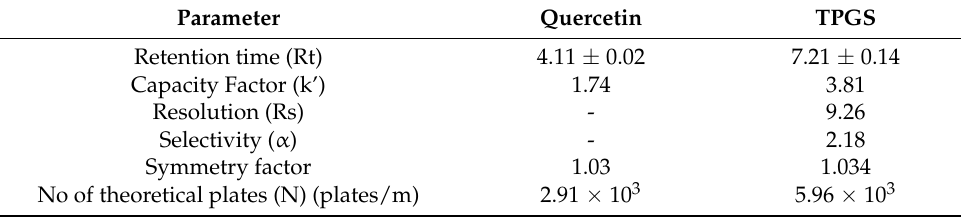
Table 1. System suitability parameters of the proposed HPLC-UV method in spiked rat plasma.